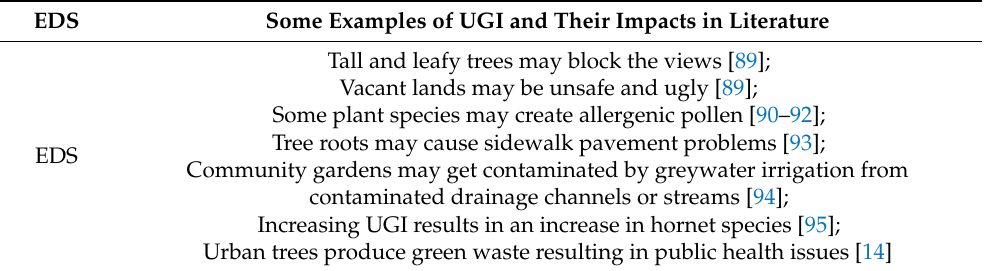
Table 2. Urban ecosystem disservices are provided by six studied small-scale green infrastructures.